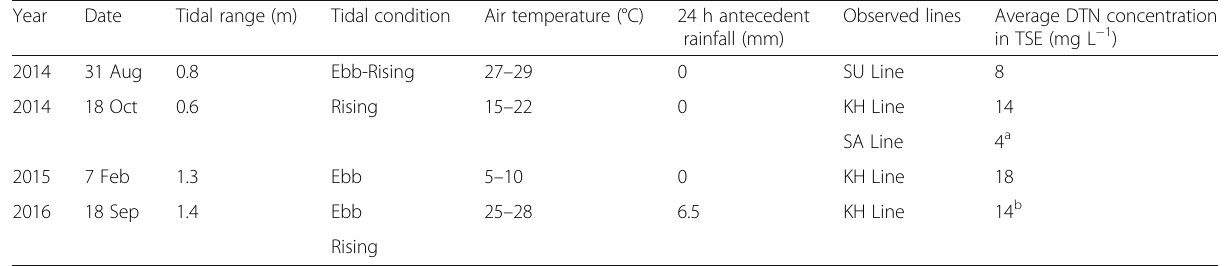
Table 1 Tide and weather conditions and average DTN concentration in the TSE during the field